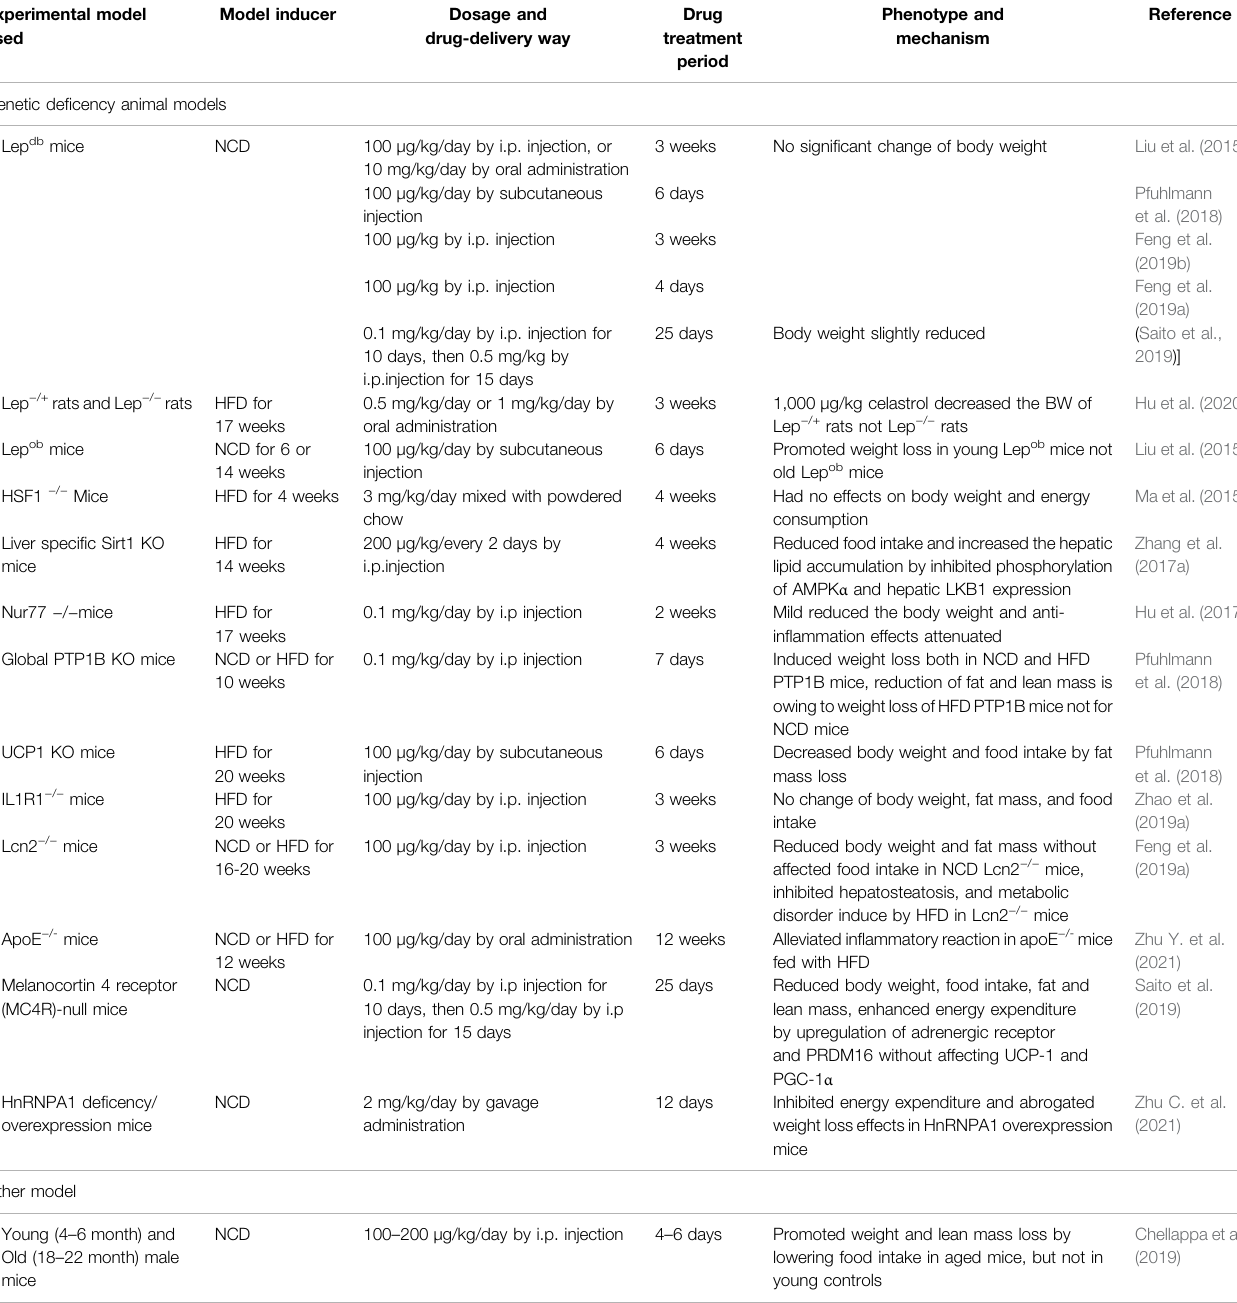
TABLE 1 | ( Continued ) The summary of preclinical studies of celastrol in HFD induced MAFLD